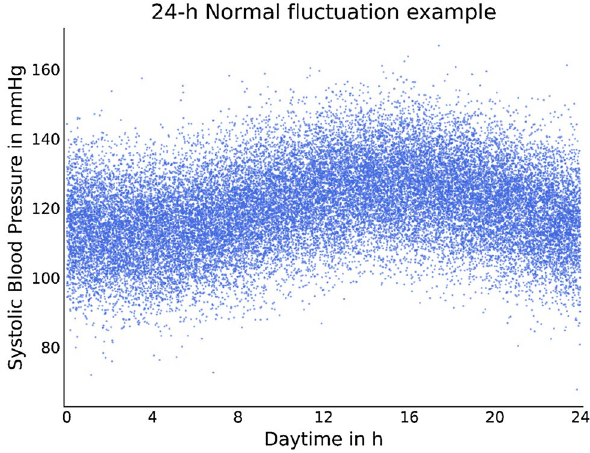
Figure 2. Plot of 30,000 samples from the systolic “24-h Normal” dataset. The normally distributed circadian rhythm is